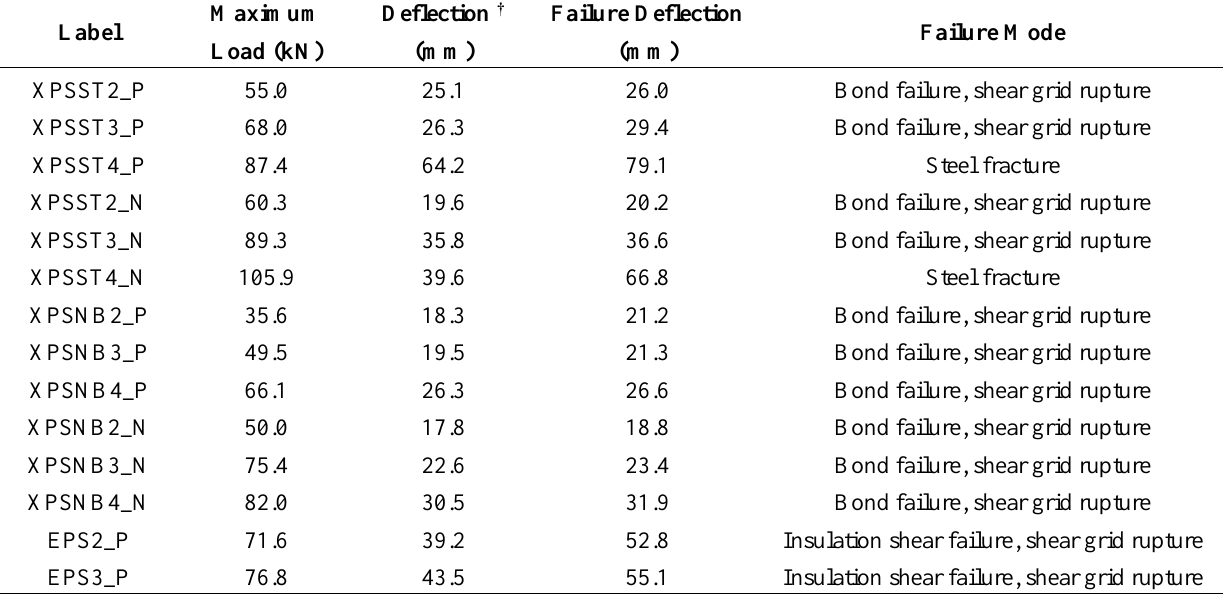
Figure 7. Flexural and shear failure mode of ICSWP specimens. Table 2. The failure mode of each specimen according to load